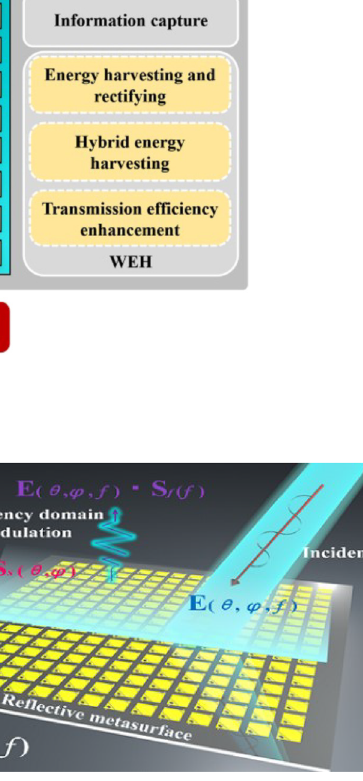
Figure 28: Frequency- and spatial-domain reconfigurable meta- surface [129]. Reprinted from [129], with the permission of American Chemical Society Publishing. © 2020, American Chemical Society.